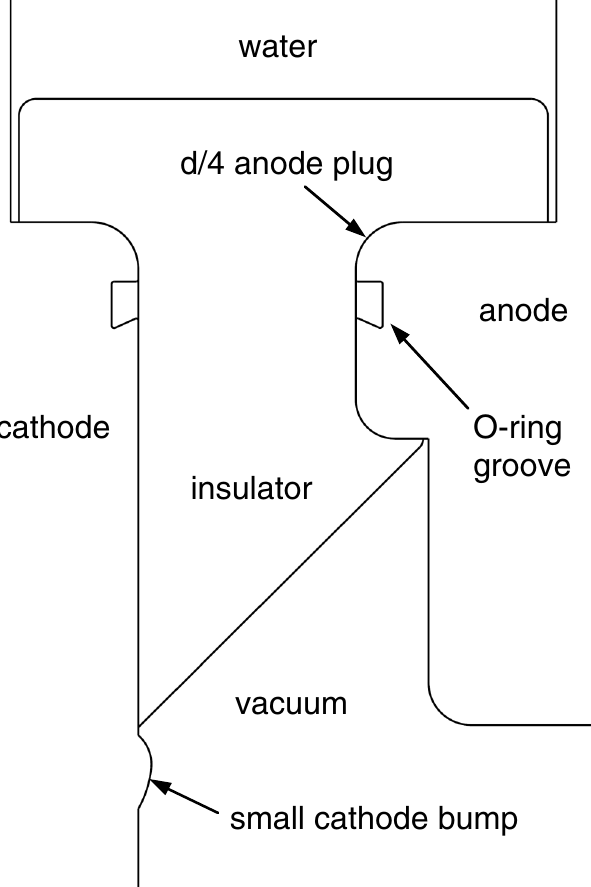
FIG. 10. Outline of the experimental arrangement. The hard- ware is cylindrically symmetric about the axis. The outer radius of the insulator is 22.48